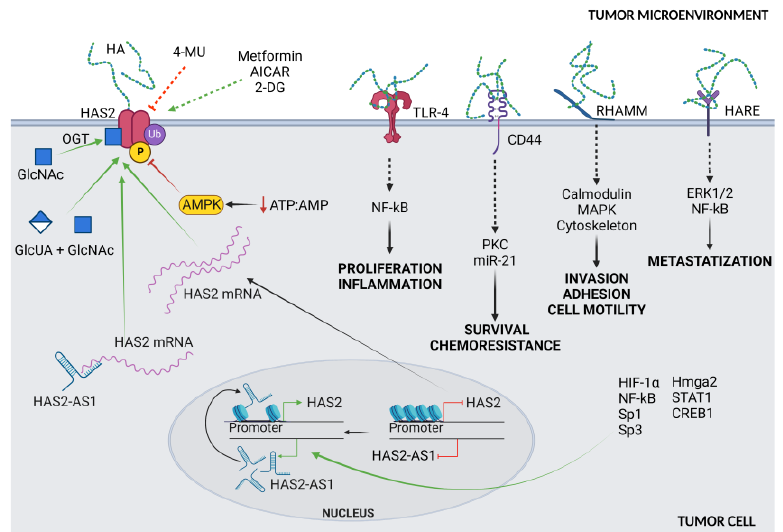
Figure 1. Summary of HA synthesis and its interaction with membrane receptors. The expression of the main synthetic enzyme HAS2 is controlled by various growth and transcription factors, as well as via epigenetic control of transcription by HAS2 antisense 1 (HAS2-AS1). Moreover, the HAS2 activity is also covalently regulated by ubiquitination, phosphorylation, O-GlcNAcylation (due to O-GlcNAc transferase, OGT). Several molecules such as 4-MU, metformin, 2-Deoxy-D-Glucose (2-DG), and the chemical AMPK-stimulating AICAR control HAS2 activity, as demonstrated in in vitro studies.